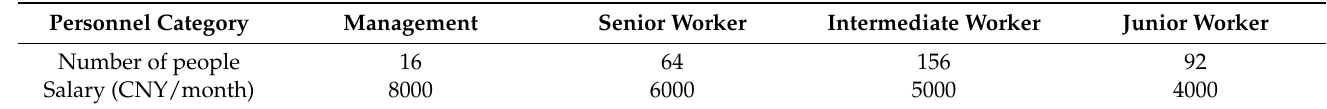
Table 1. Distribution of human resources category and wage level of bridge and tunnel operation and maintenance unit of the Shuohuang Railway Company’s operation and maintenance project.